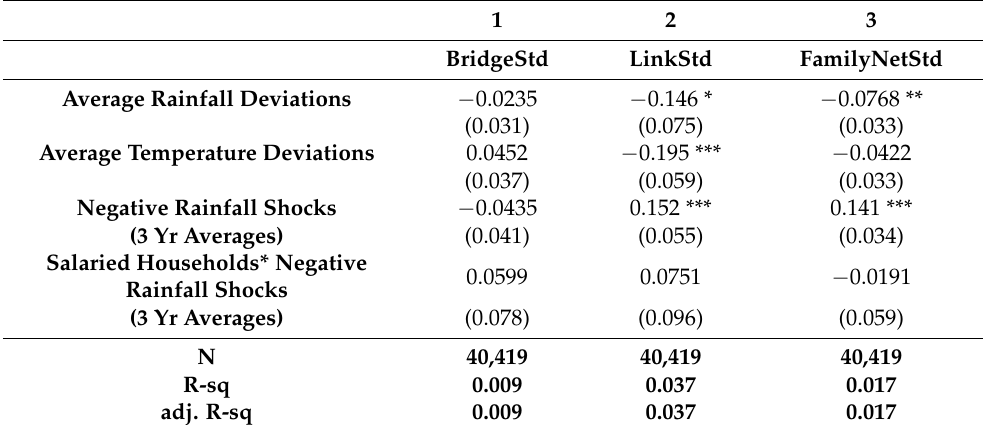
Table A6. Results assessing the impacts of negative rainfall shocks on households earning salary income.